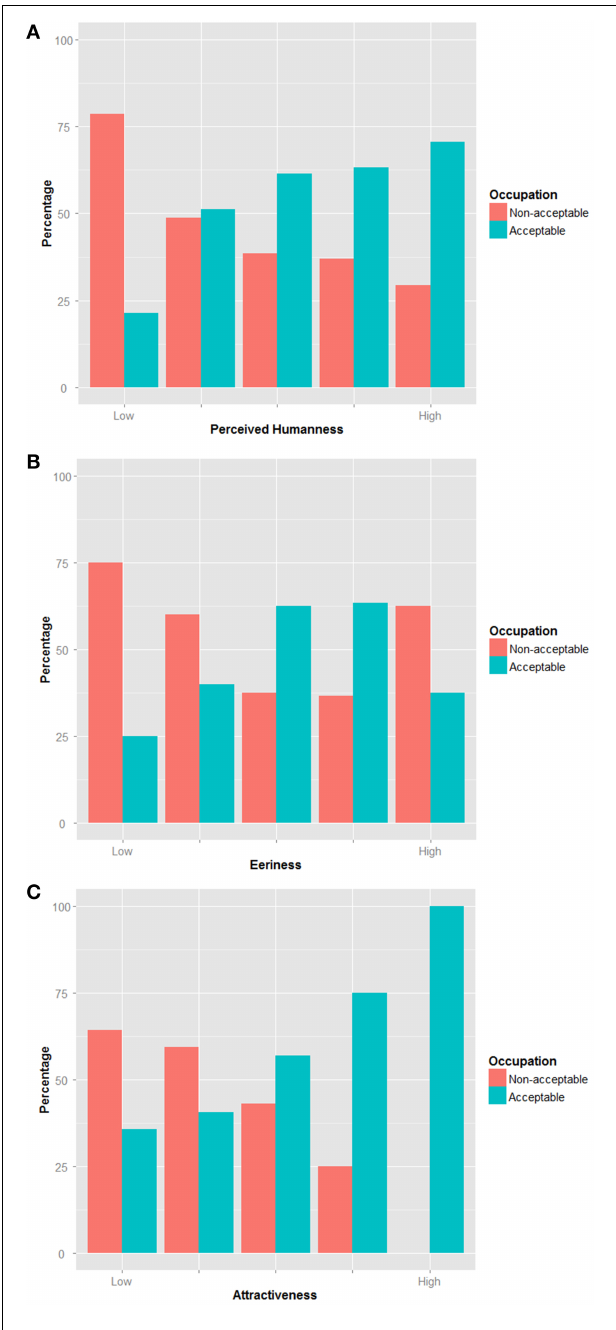
FIGURE 5 | Robot occupation acceptability. The images represent the occupation acceptability of related to the participants’ ratings of (A) Perceived Humanness; (B) Eeriness; (C)